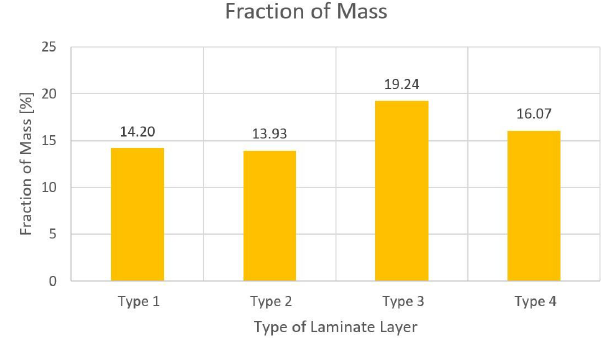
Figure 5: Tensile strain characteristics of HCGFRP in each lamina configuration